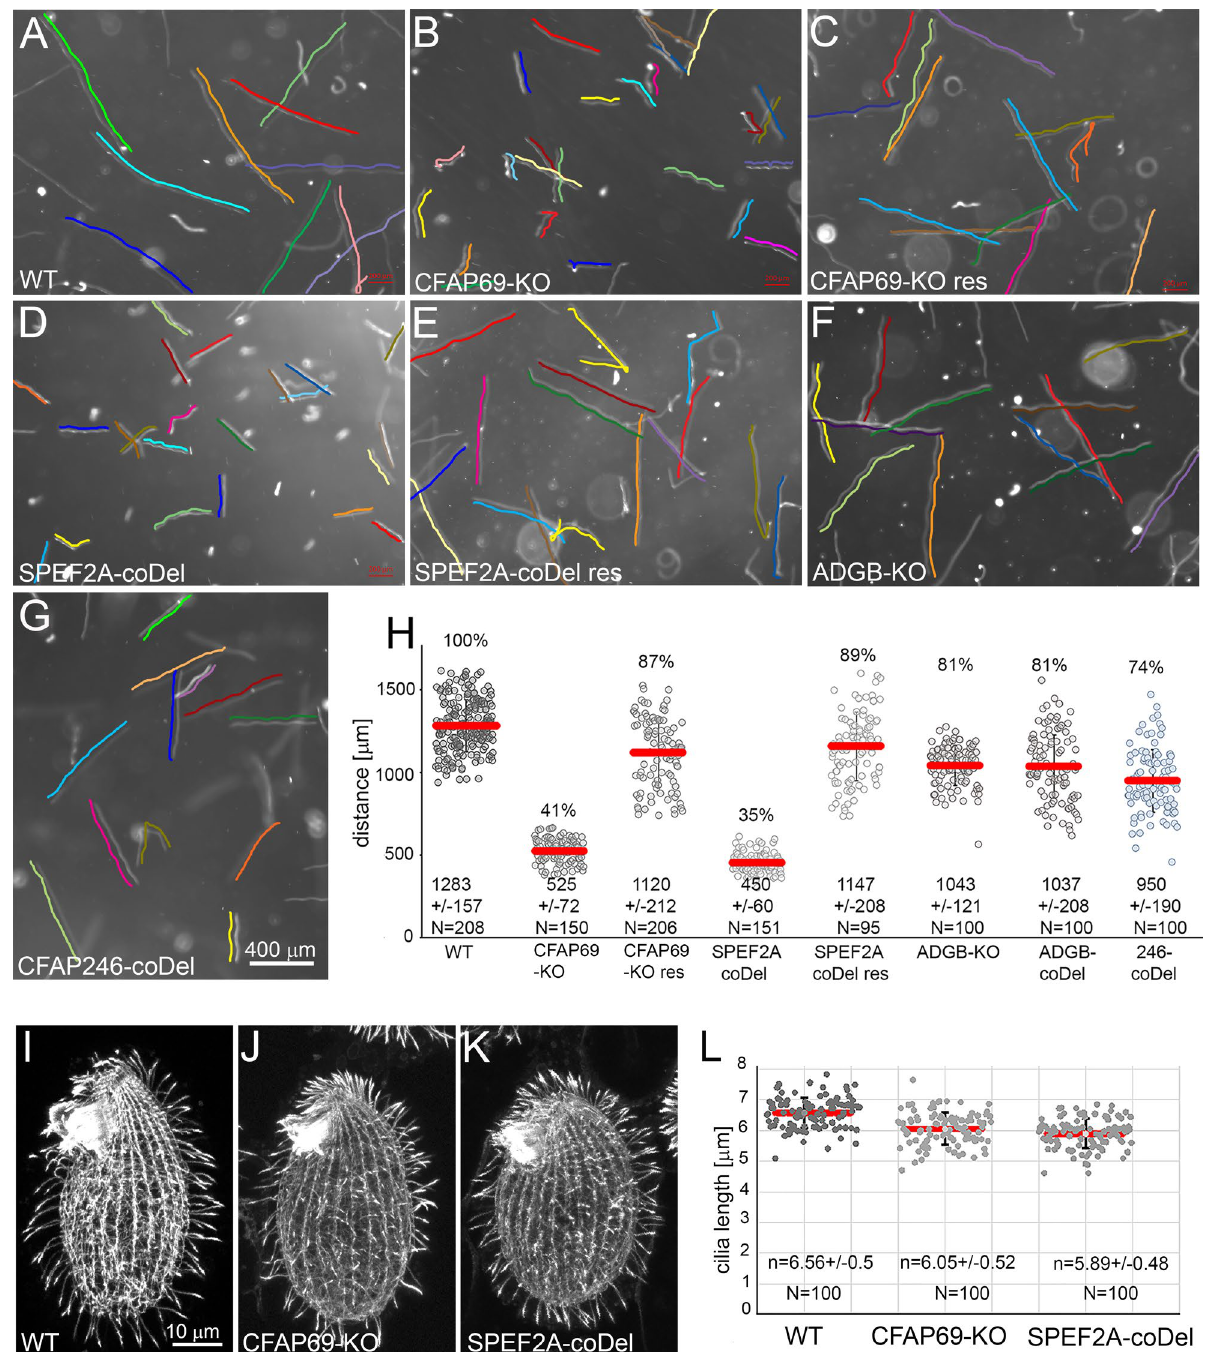
Figure 2. Tetrahymena mutant cells with deleted CFAP69 or SPEF2A swim with reduced velocity. ( A–G) Swimming paths of wild type ( A ) and mutant cells: CFAP69-KO ( B ), CFAP69-KO rescued ( C ), SPEF2A-coDel ( D ), SPEF2A-coDel rescued ( E ), ADGB-KO ( F ), and CFAP246-coDel ( G ). All swimming paths were recorded for 3.2 s at RT using video camera. The cells trajectories are indicated by parallel color lines. Bar = 400 µm. ( H) Graph showing the comparison of the distances swum by wild-type (WT) and analyzed mutants during 3.2 s. Error bars represent standard deviation. The traveled distance with standard deviation and number of the measured trajectories (N) are indicated at the bottom of the graph. Numbers above the graph indicate % of the distance swum by wild-type cells. Note that ADGB-coDel cells (knockdown) and ADGB-KO cells swam at similar rate. ( I – L ) Analysis of the cilia length. ( I – K) Confocal immunofluorescence images of wild-type ( I ) and mutant cells ( J – K ) stained with anti-α-tubulin antibodies to visualize cilia. ( L ) Graph showing a length of cilia assembled by analyzed cells. n – mean cilium length with standard deviation, N – number of measured cilia. Observed shortening of cilia in both mutants is statistically significant ( p < 0.0001,